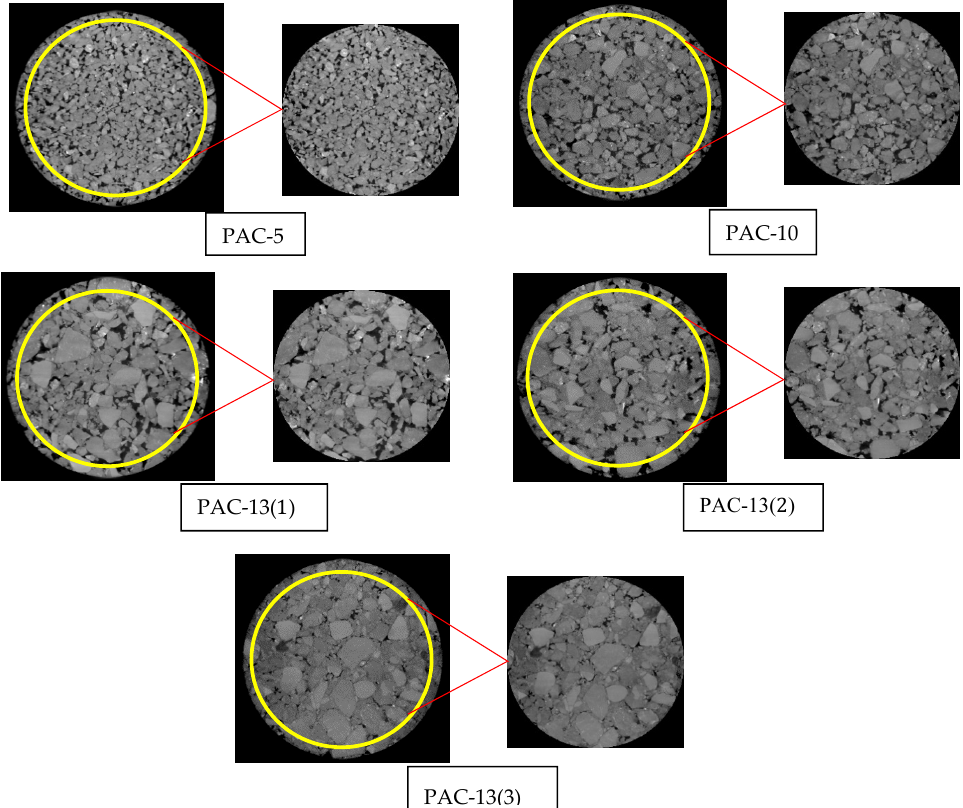
Figure 1. Illustration of cropping a region of interest from the original slices.